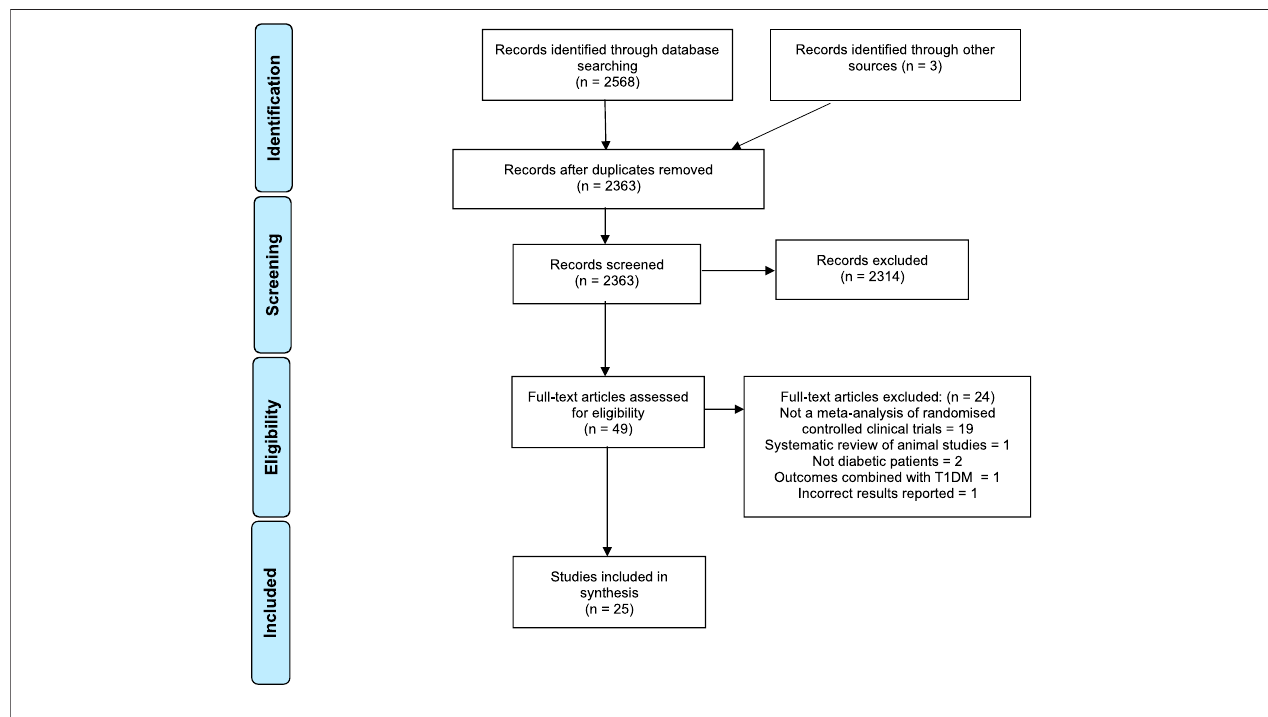
FIGURE 1 | PRISMA fl